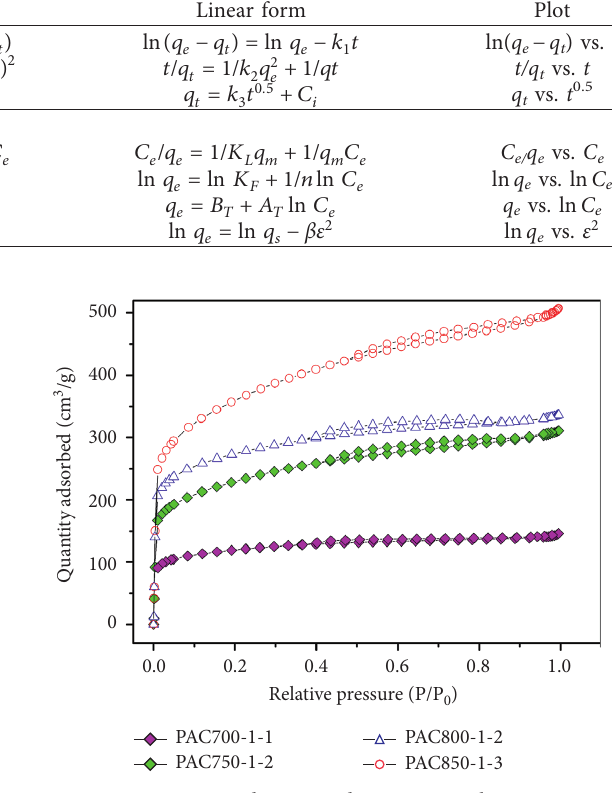
Figure 1: N 2 adsorption-desorption